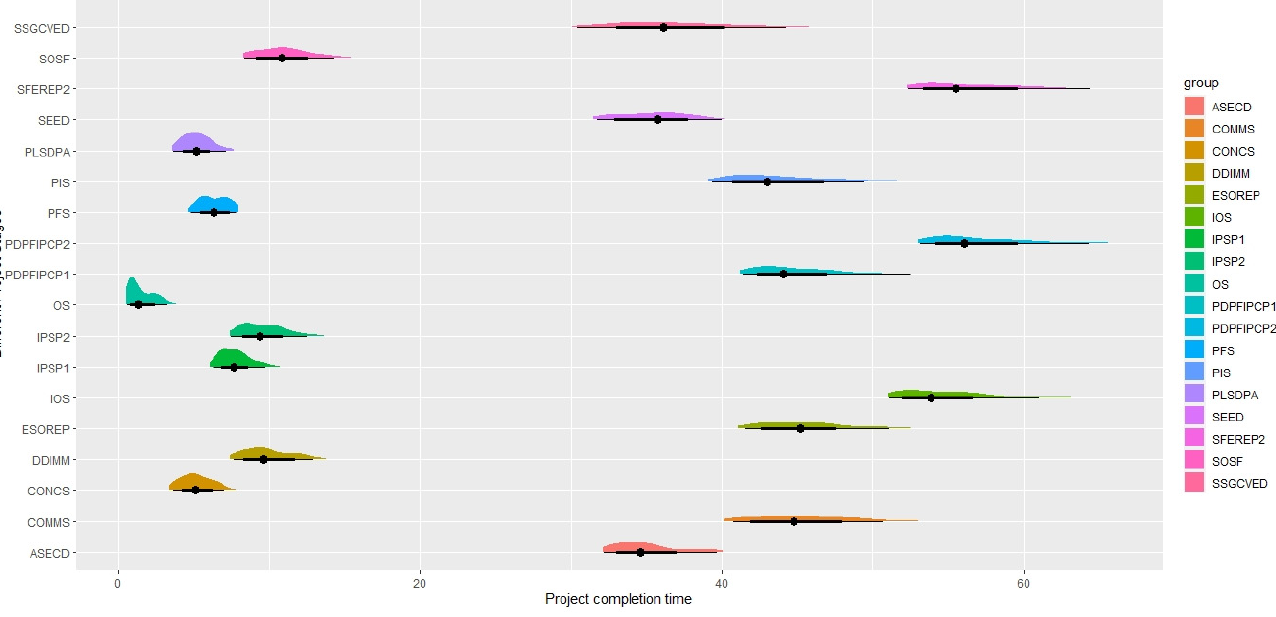
Figure 9. Individual project stages can be visualised in terms of the distribution of changes in the assumed time schedule on the timeline of the entire project.